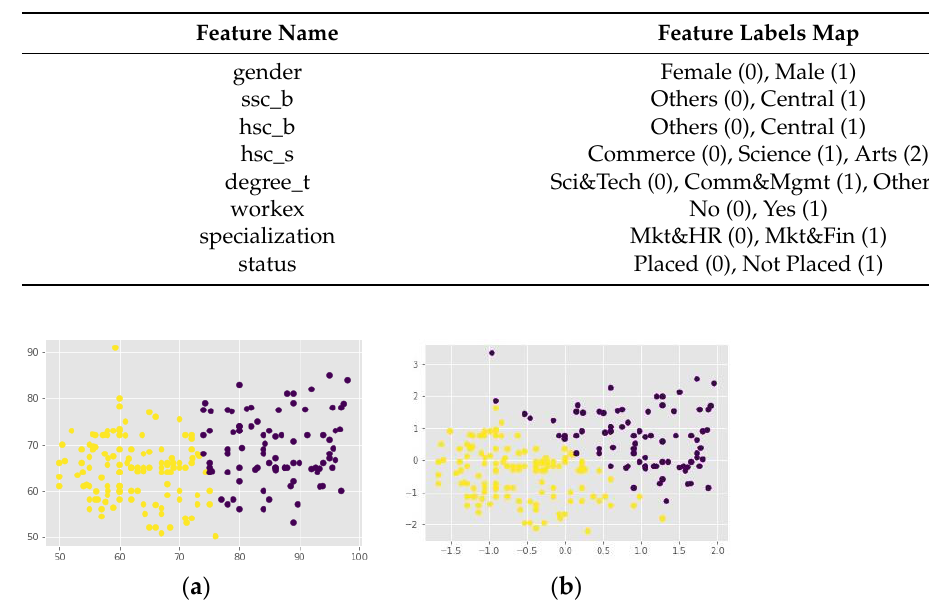
Table 2. Label encoding conversions.